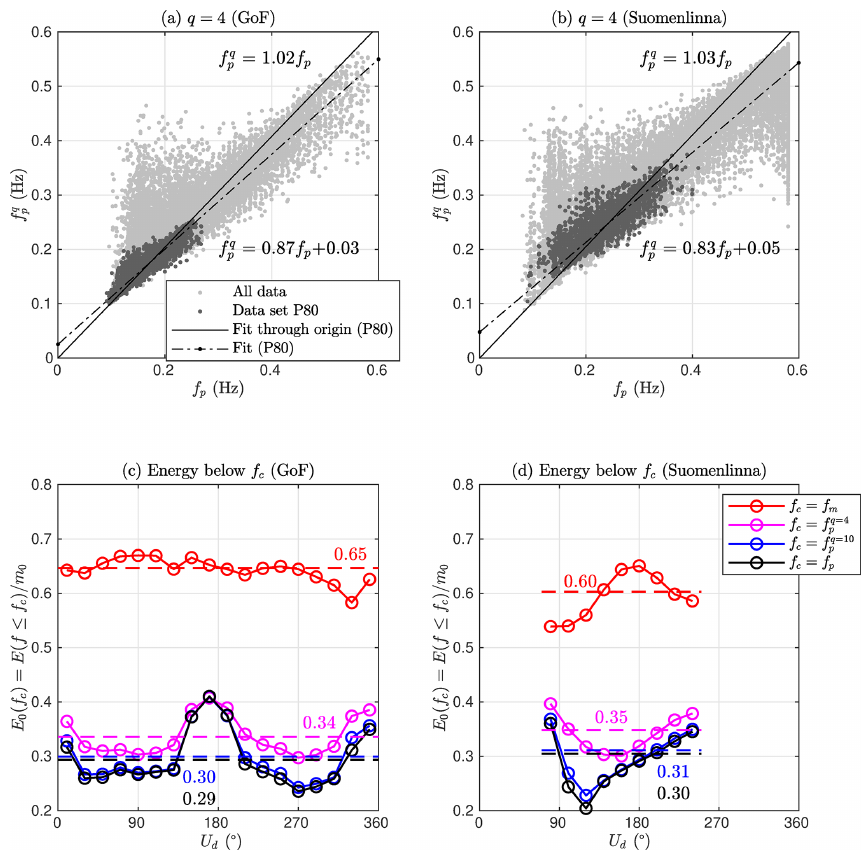
Figure 9. The characteristic wave frequency f c = f q p compared to f p for different values of q at the open sea (GoF, left column) and in the middle of the archipelago (Suomenlinna (T2), right column). Note that f m is identical to f q